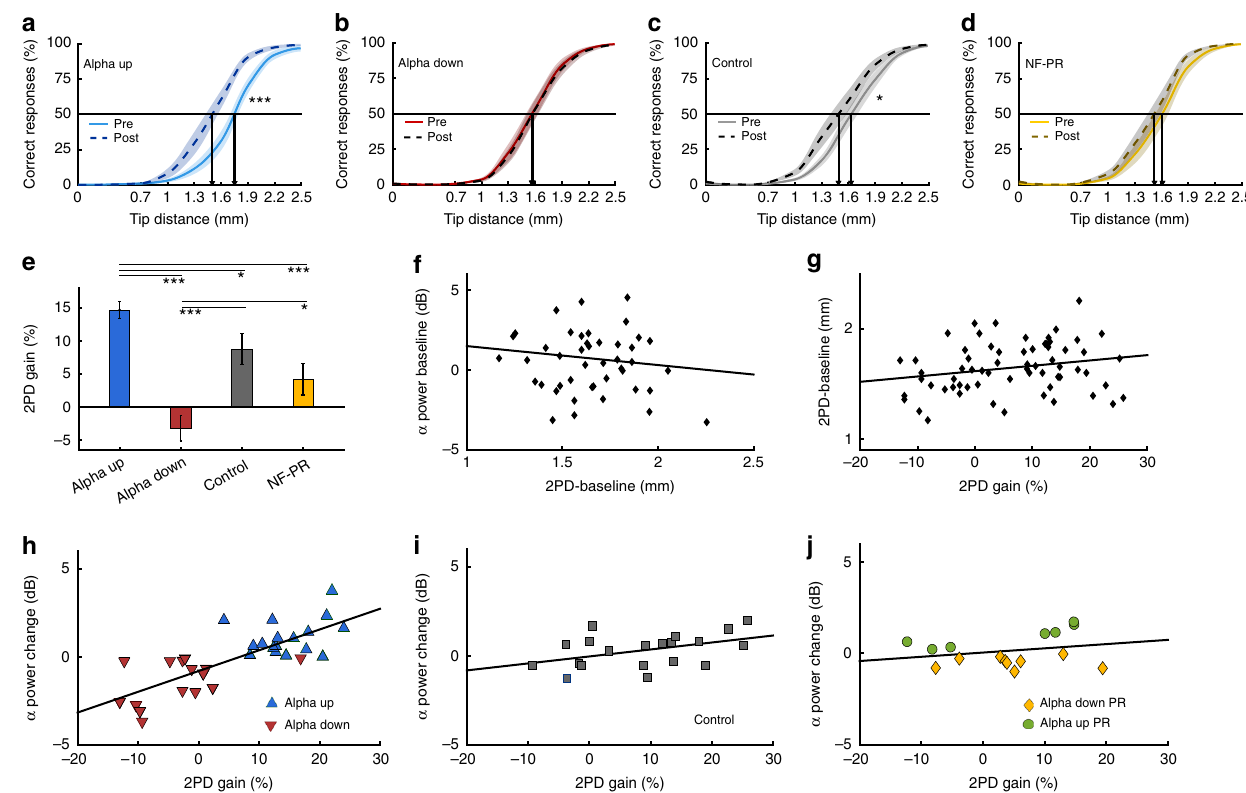
Fig. 3 Analysis of the effect of neurofeedback training on perceptual learning. a – d Psychometric curves depicting tactile acuity before and after 20 min of repetitive sensory stimulation. Learning effects are indicated by a shift of the curve to the left. Data are presented as mean ± SEM. * p < 0.05; *** p < 0.001; two-way mixed ANOVA . e Quantitative analysis demonstrating striking group differences in tactile acuity gain. Data are presented as mean ± SEM. * p < 0.05; *** p < 0.001; one-way ANOVA . f No relationship between baseline alpha power and baseline tactile acuity thresholds was detectable. g Baseline tactile acuity thresholds and repetitive sensory stimulation-induced tactile acuity gain were equally unrelated. h Regression of the percent gain in tactile acuity on alpha power changes compared to baseline for the NF training groups reveals a strong connection. This connection was smaller for participants from the control group ( i ) while NF-paradoxical-responders (NF-PR; j ) showed no connection at all (alpha up: n = 17; alpha down: n = 15; control: n = 20; NF-PR: n = 16). All alpha power values were normalized for baseline values of day